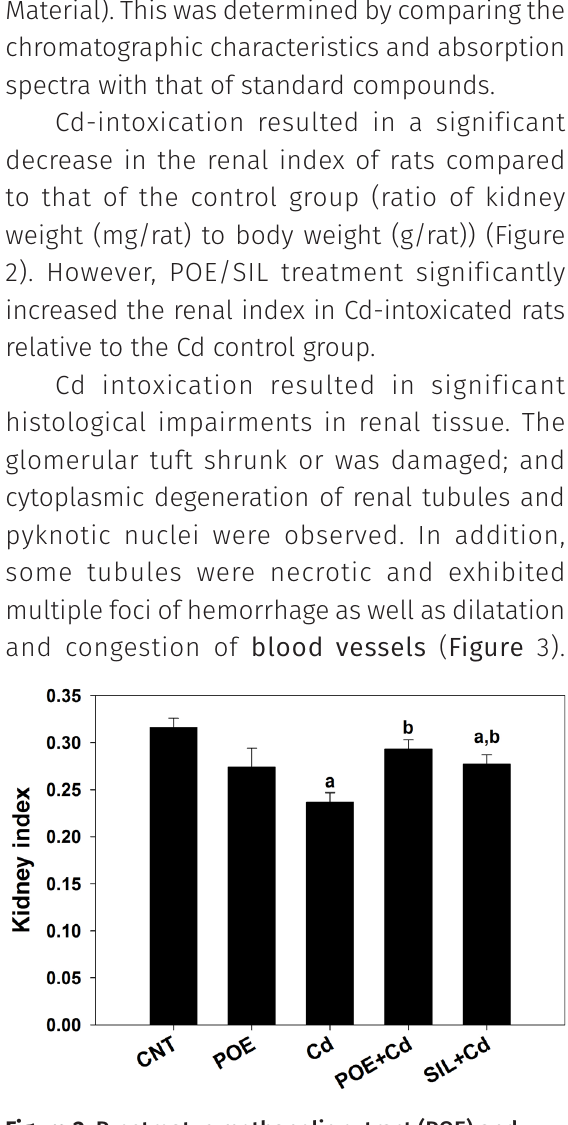
Figure 2. P. ostreatus methanolic extract (POE) and silymarin (SIL) treatment improved the kidney index of female albino rats in response to Cd-intoxication. Values are presented as mean ± SE.